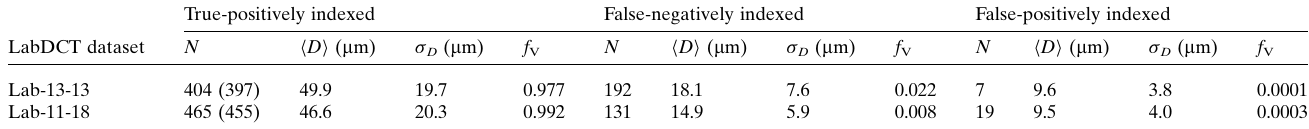
Table 2 Statistics of the grains within the four different indexing categories in the LabDCT datasets. N denotes the number of grains, h D i is the mean grain size, (cid:4) D is the standard deviation of the grain size distribution and f V is the volume fraction. The statistics of one-to-one and one-to-multi indexed grains are merged and labeled as true-positively indexed. The values in the bracket of N for the true positives are the number of one-to-one indexed grains.